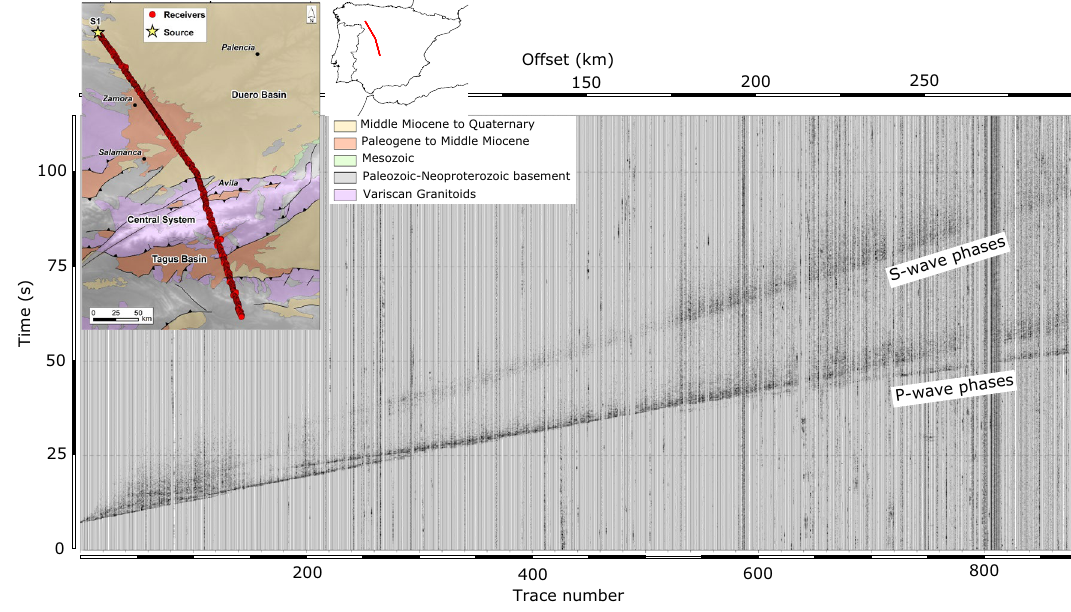
Figure 1. Vertical component record of the S1 shot along the CIMDEF profile, represented without time reduction after applying a 1–15 Hz band-pass filtering. Different P-wave phases can be identified even at this large scale. S-waves are also identified all along the profile. The insets show a simplified geological map of the sampled zone and its location in the Iberian Peninsula. This map has been produced using ArcGis 10.5 (https:// www. esri. com/ en- us/ arcgis/ produ cts/ arcgis- deskt op/). The geological features are from the Geological Survey of Spain (IGME) 14 and the topography is from CIAT-CSI SRTM (http:// srtm. csi. cgiar. org) 15